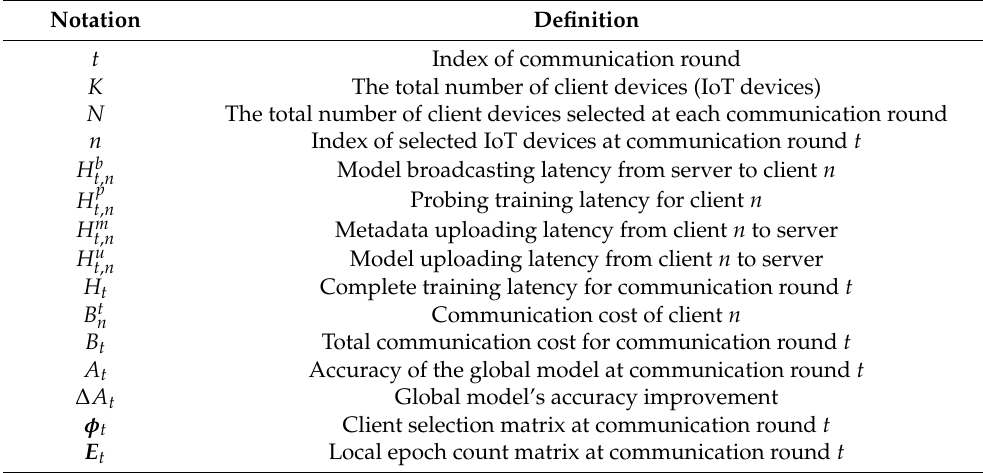
Table 2. List of key variables defined in the system